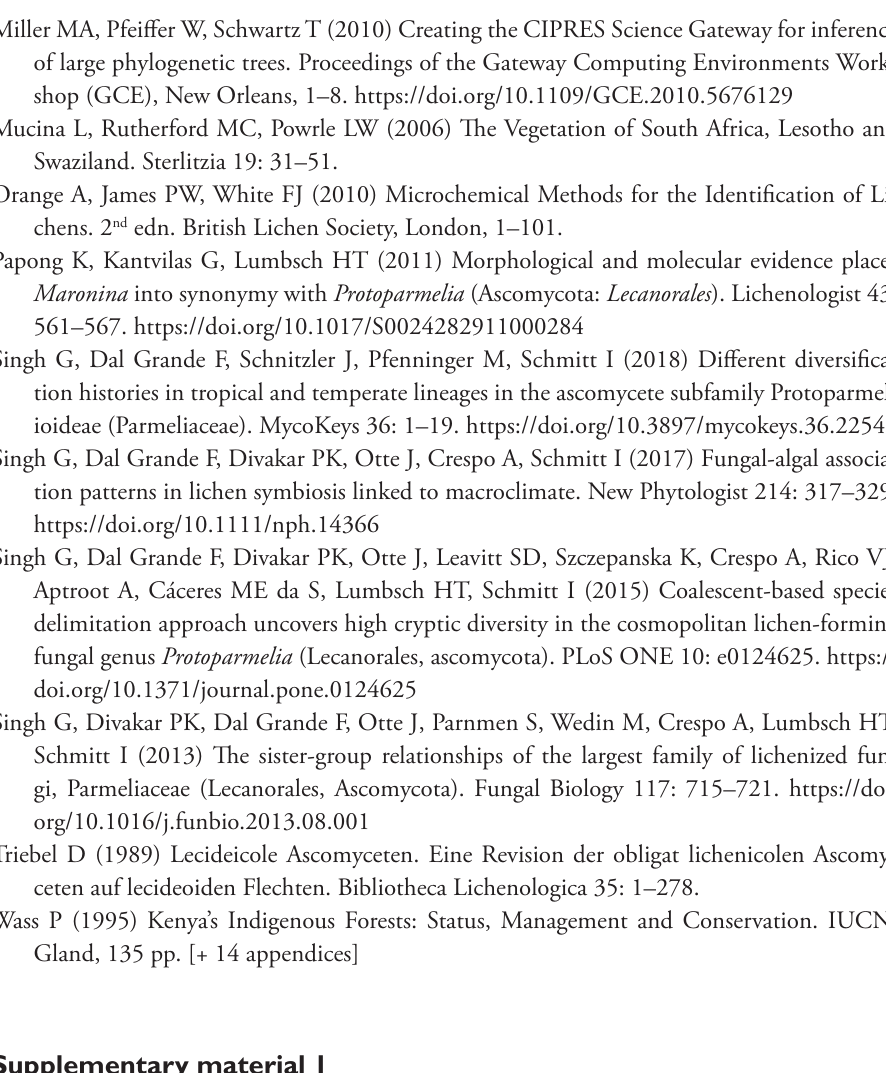
Table S1: List of primers used in this